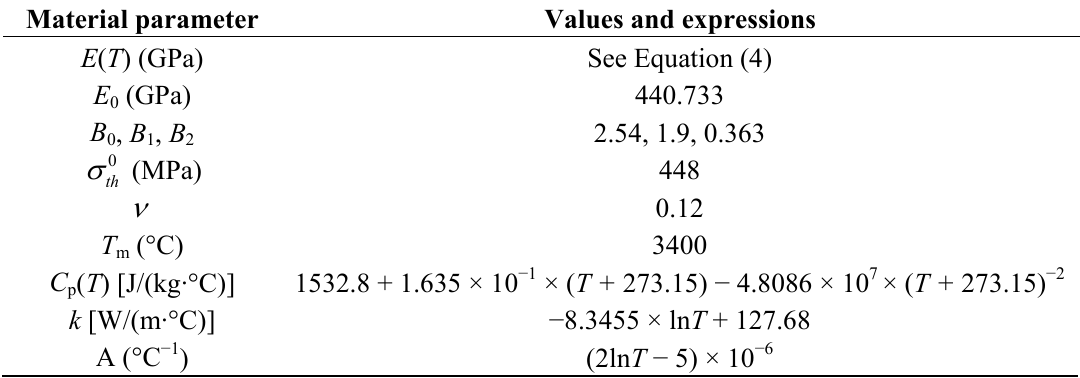
Table 1. Temperature-dependent material properties of HfB